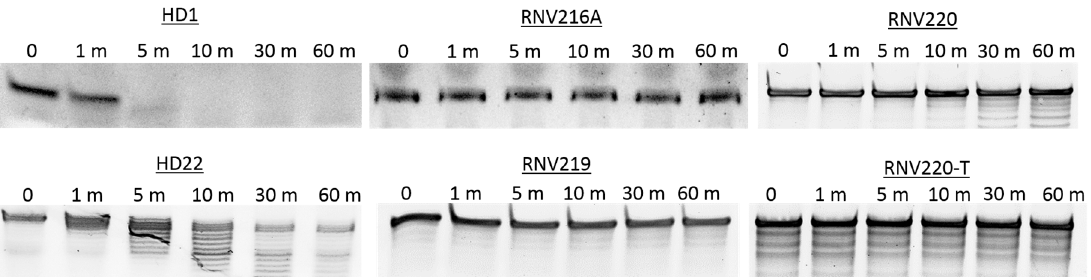
Figure 4. Nuclease stability analysis of the aptamers used in this study. (m = minute).